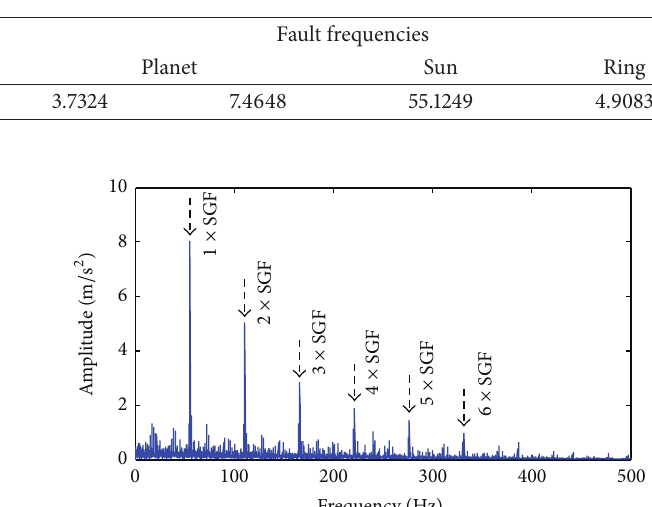
Table 3: Characteristic frequencies (Hz).